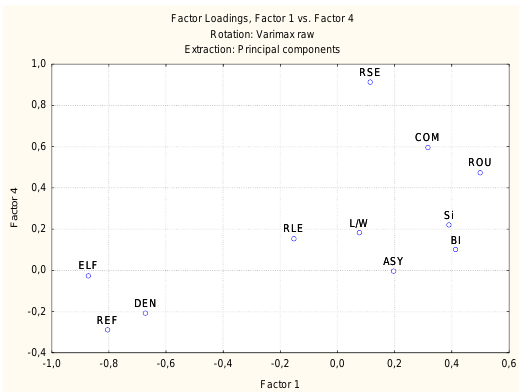
Figure 6. 2D presentation of the values of factor loadings of the first (X axis) and the fourth factor (Y axis) from the Table 4b.